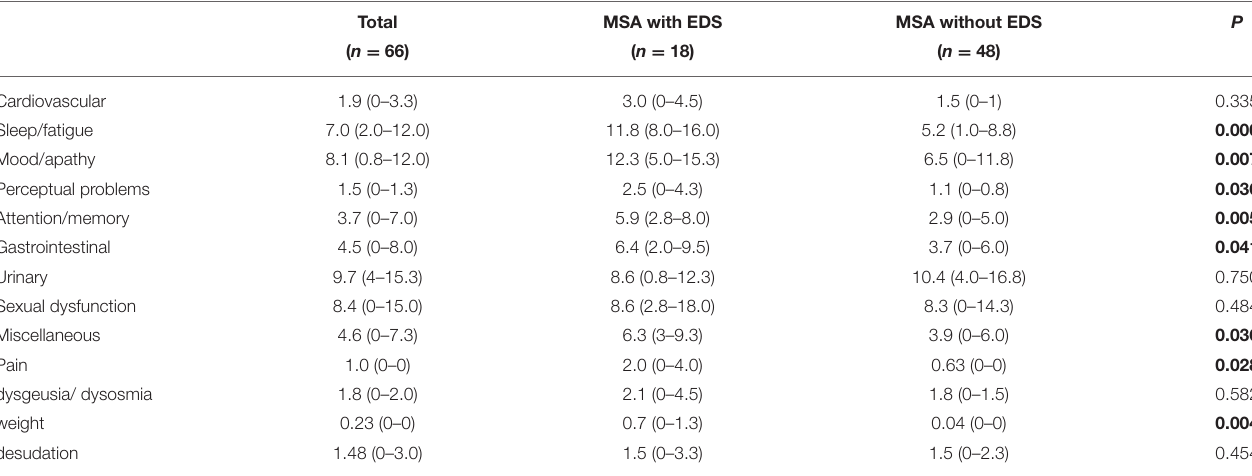
TABLE 2 | Non-motor symptoms scale (NMSS) of MSA with and without